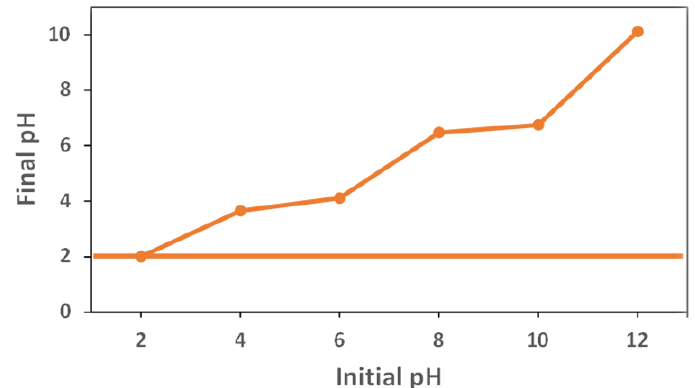
Figure 2. Point of zero charge for graphene oxide.